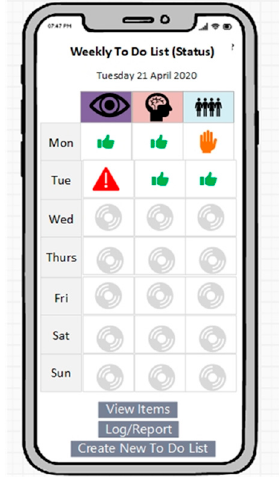
Figure 5. Tracking progress on wellbeing plan and targets.